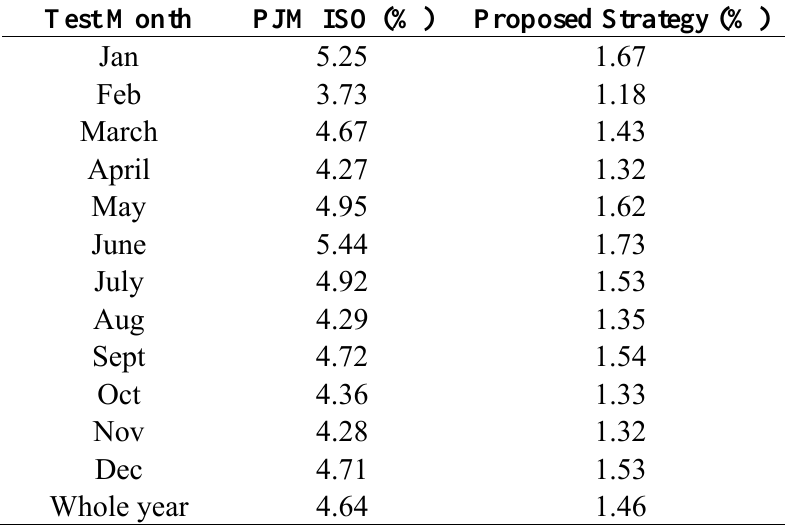
Table 4. Comparison of the STLF results of the proposed strategy with the STLF results of the PJM ISO for the 12 months of year 2009 (the reported results are in terms of MAPE